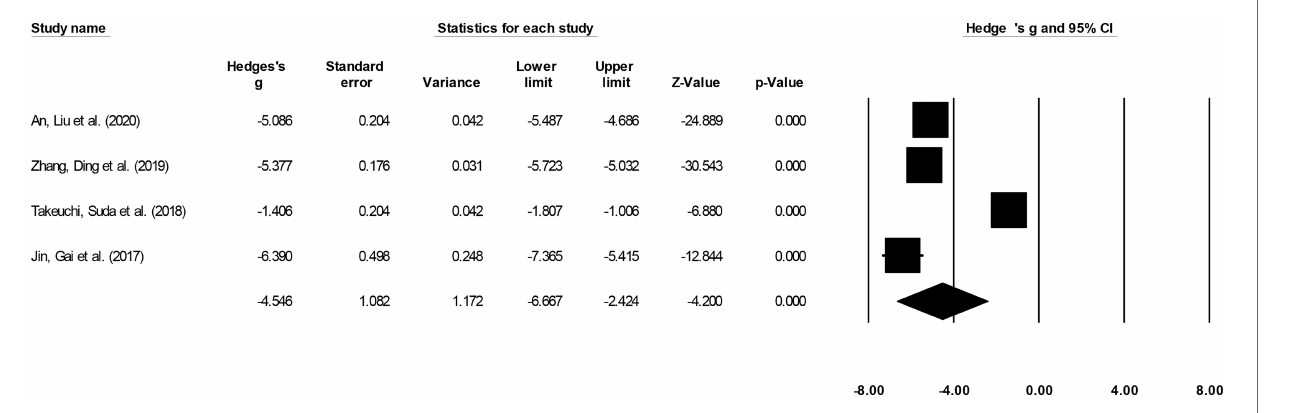
FIGURE 5 | The forest plot for studies evaluating the procedure duration in patients with super fi cial esophageal squamous cancer undergoing endoscopic submucosal dissection or esophagectomy. The weighted effect sizes are presented as black boxes whereas 95% con fi dence intervals are presented as whiskers. A